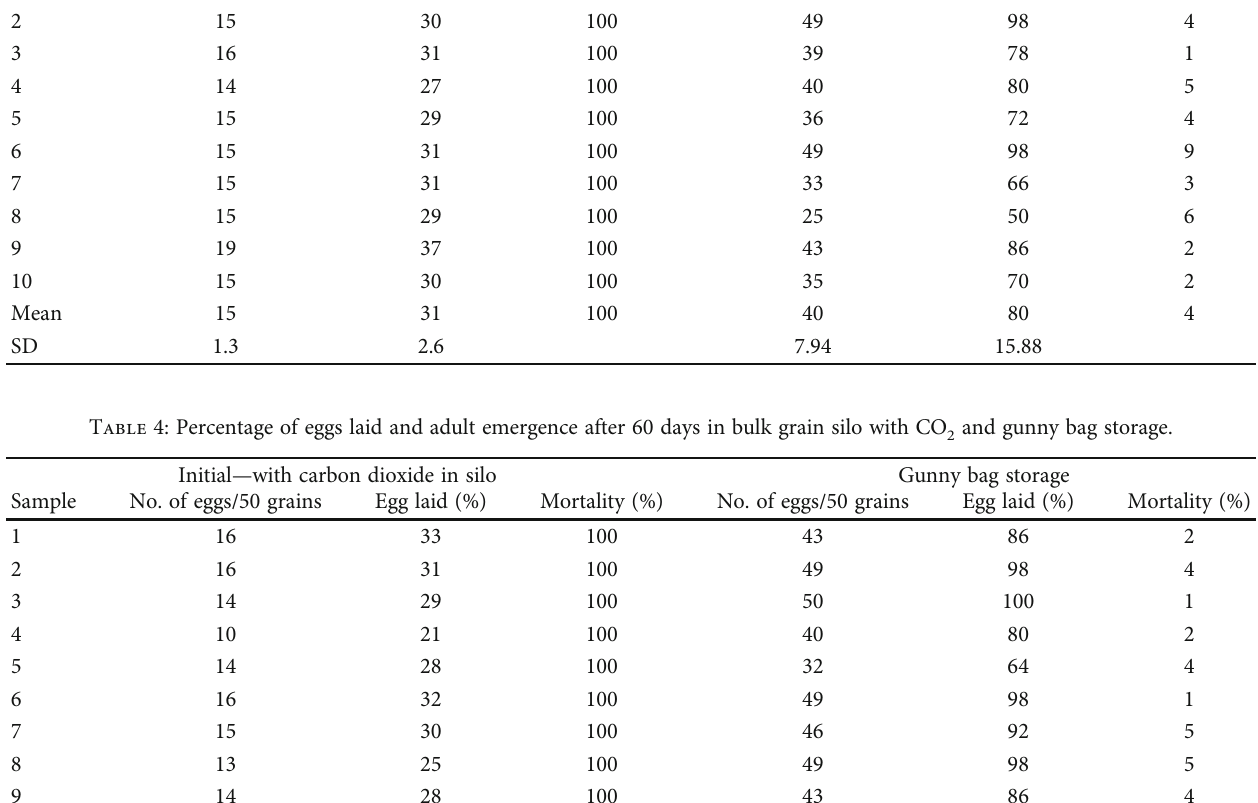
Table 3: Percentage of eggs laid and adult emergence after 30 days in bulk grain silo with CO Initial — with carbon dioxide in silo Gunny bag storage